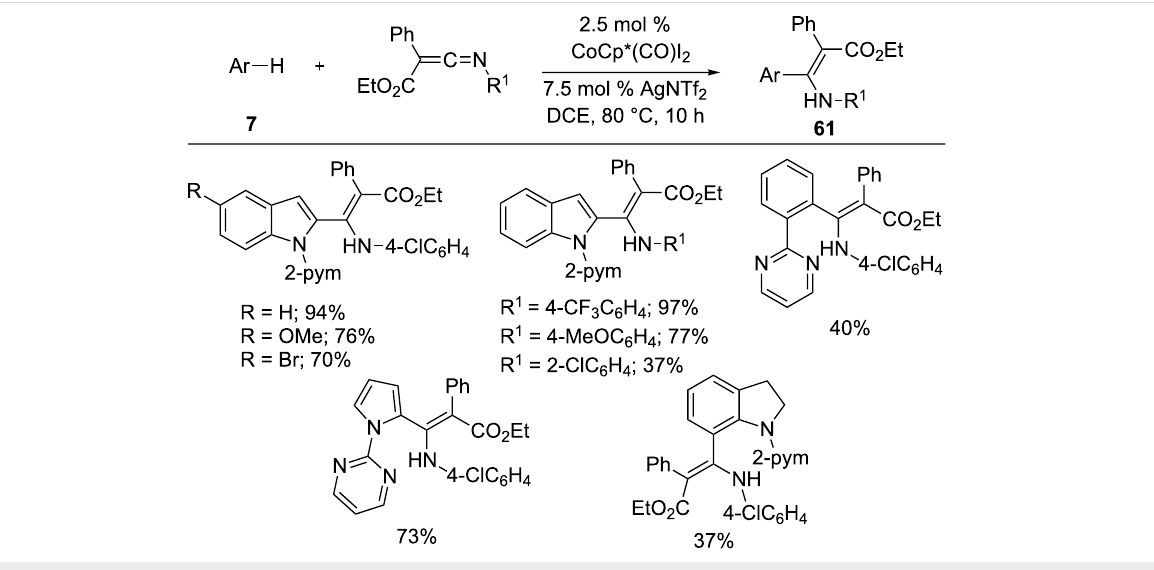
Scheme 38: Co(III)-catalyzed addition of arenes to